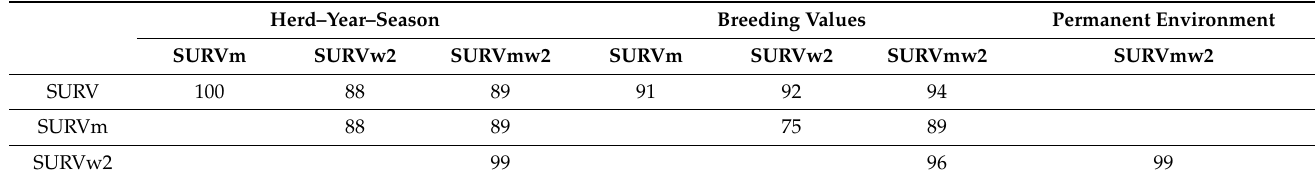
Table 7. Corelation among calculation methods in